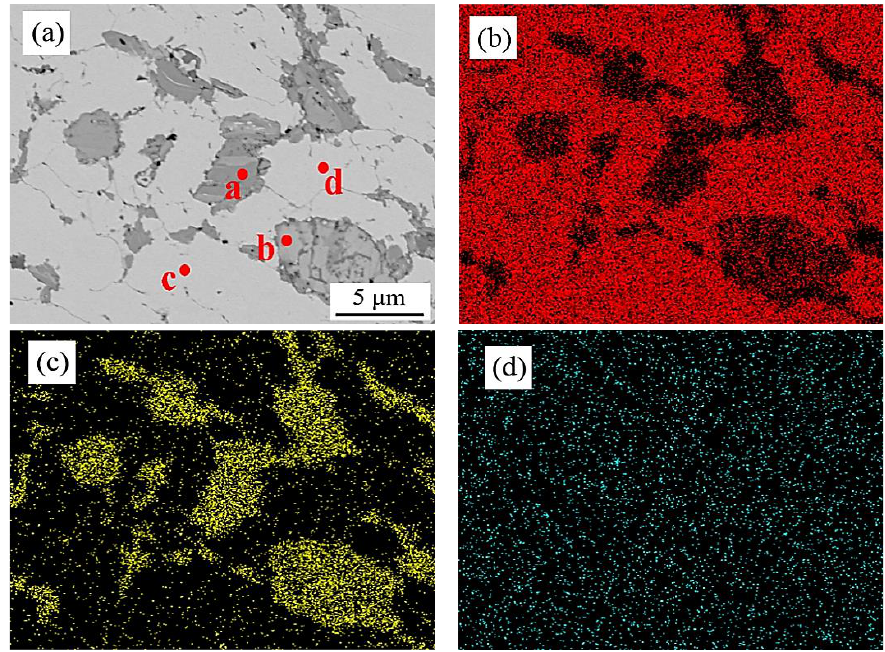
Figure 4. Typical morphology and EDS mapping of Ti 3 AlC 2 /Cu composites when the volume frac- tion of Ti3AlC2 is 30 vol.%: ( a ) SEM micrograph and ( b ) scanning results of the Cu element, ( c ) the Ti element and the ( d ) Al element.